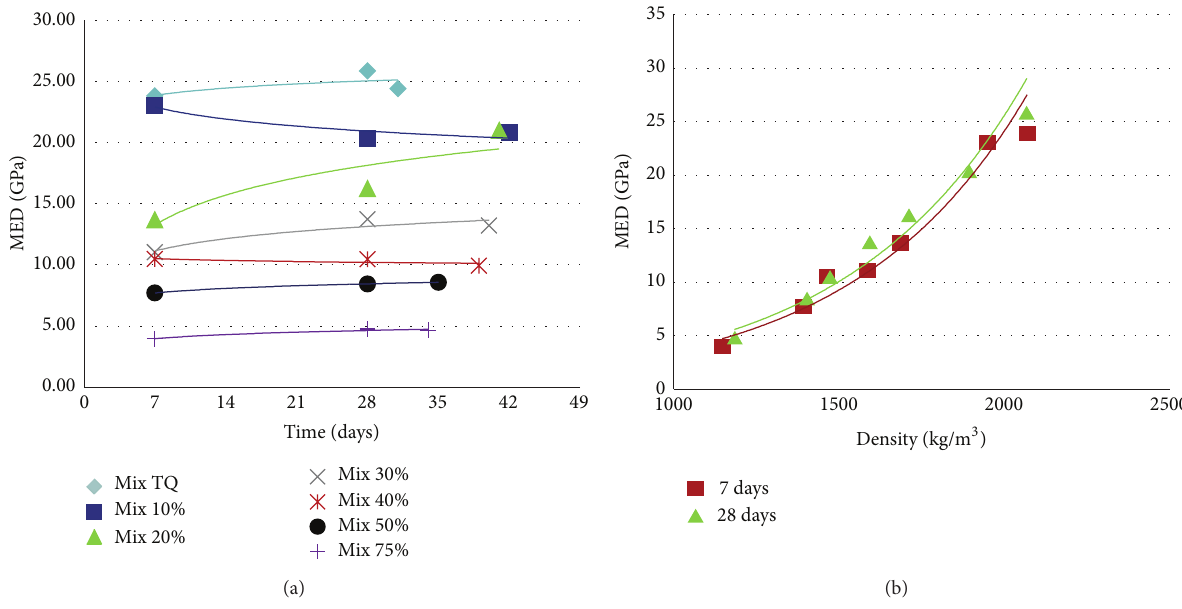
Figure 9: MED of rubber cement composites against (a) curing time; (b)